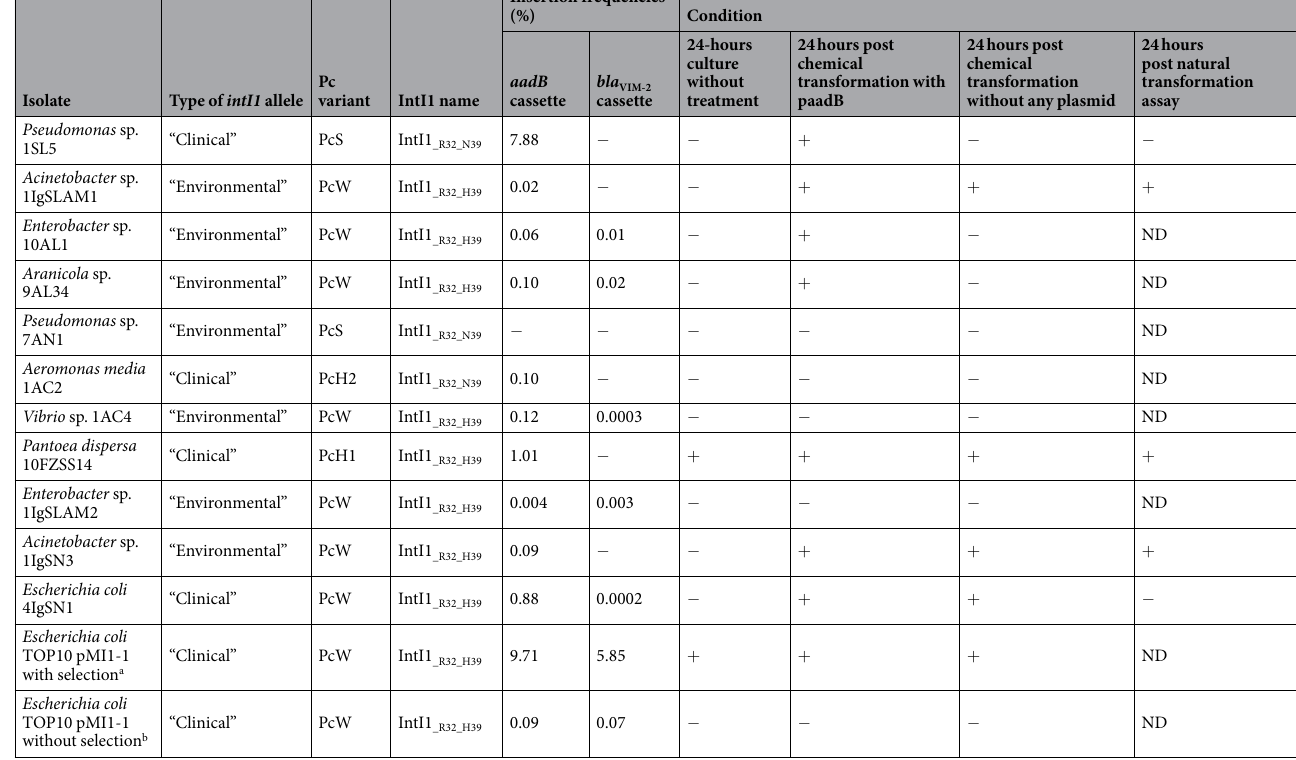
Table 1. Type of intI1 allele (“clinical” or “environmental”), Pc variants, intI1 expression at different conditions and insertion frequencies of the ARGC ( aadB or bla VIM-2 gene cassette) in the native attI1 sites of the environmental strains. The 11 intI1 -positive environmental strains were artificially transformed with plasmid paadB or pVIM2 in order to estimate the insertion frequencies of aadB and bla VIM-2 gene cassettes, respectively. E . coli TOP10 pMI1-1 was used to compare results. − indicates a negative result. Insertion frequencies are the mean value of four independent assays. a Transformants cells were positively selected by the addition of ampicillin (100 µ g/ml) and kanamicin (25 µ g/ml). b Transformants cells were not positively selected by